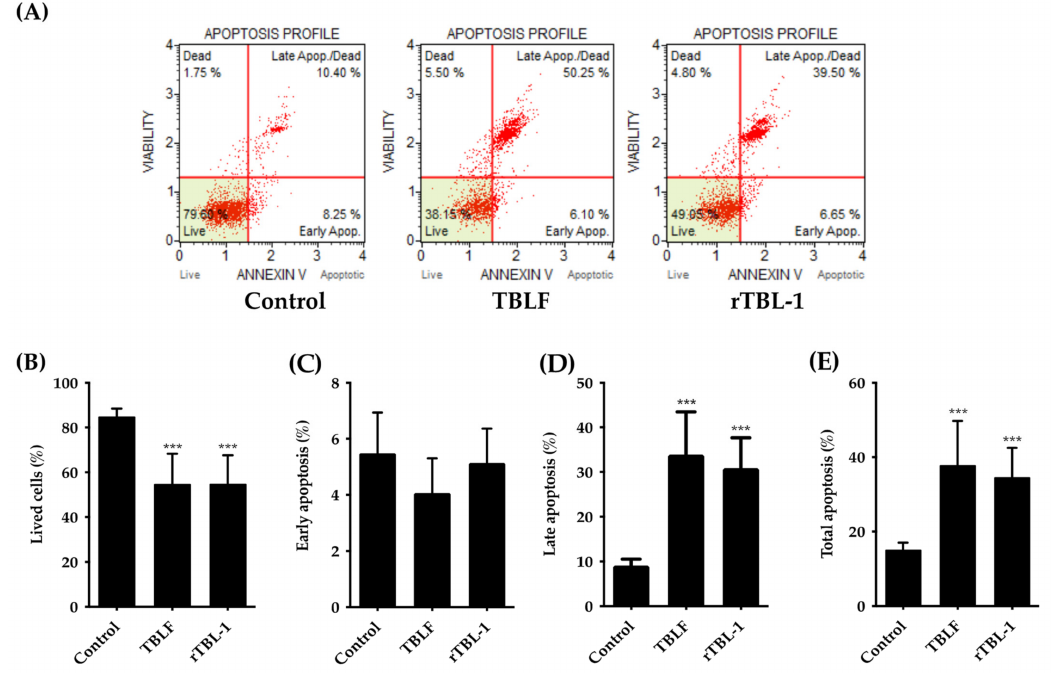
Figure 1. rTBL-1 induced apoptosis in HT-29 cells. Cells were treated with TBLF-LC 50 or rTBL-1-LC 50 for 8 h. ( A ) Flow cytometry representative dot plots for apoptosis. ( B ) Cells viability percentage. ( C ) Early apoptosis percentage. ( D ) Late apoptosis percentage. ( E ) Total apoptosis